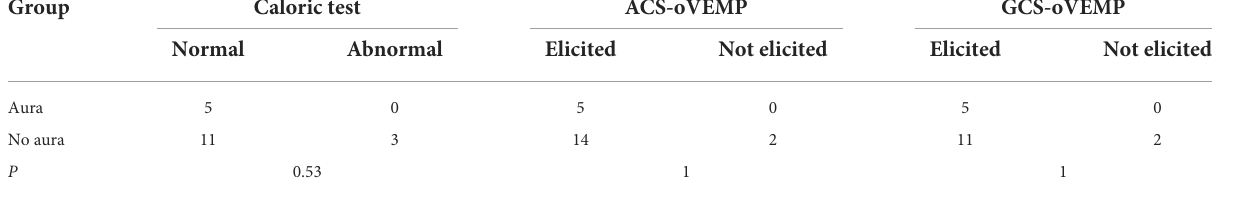
TABLE 5 Comparison of children with or without aura.